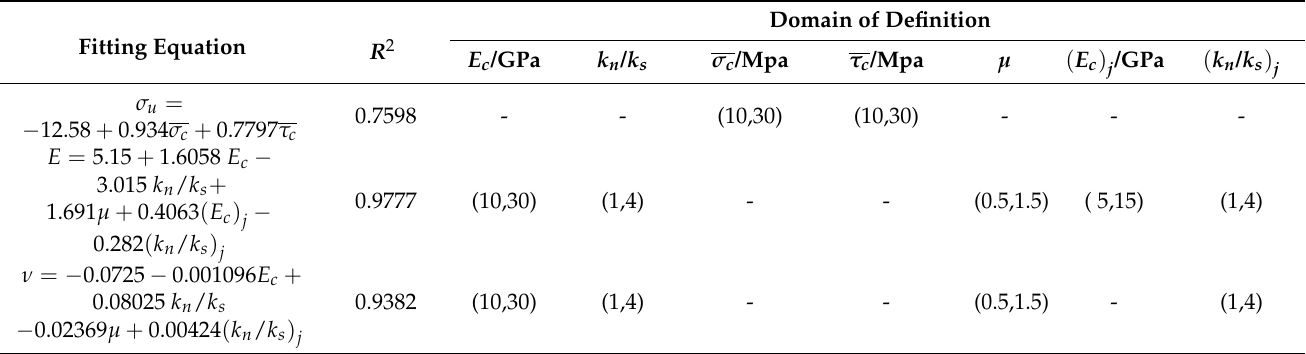
Table 8. Regression analysis of orthogonal experimental